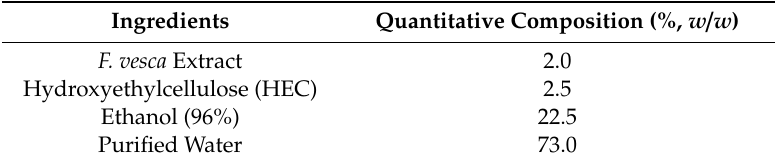
Table 1. Qualitative and quantitative composition of F. vesca based